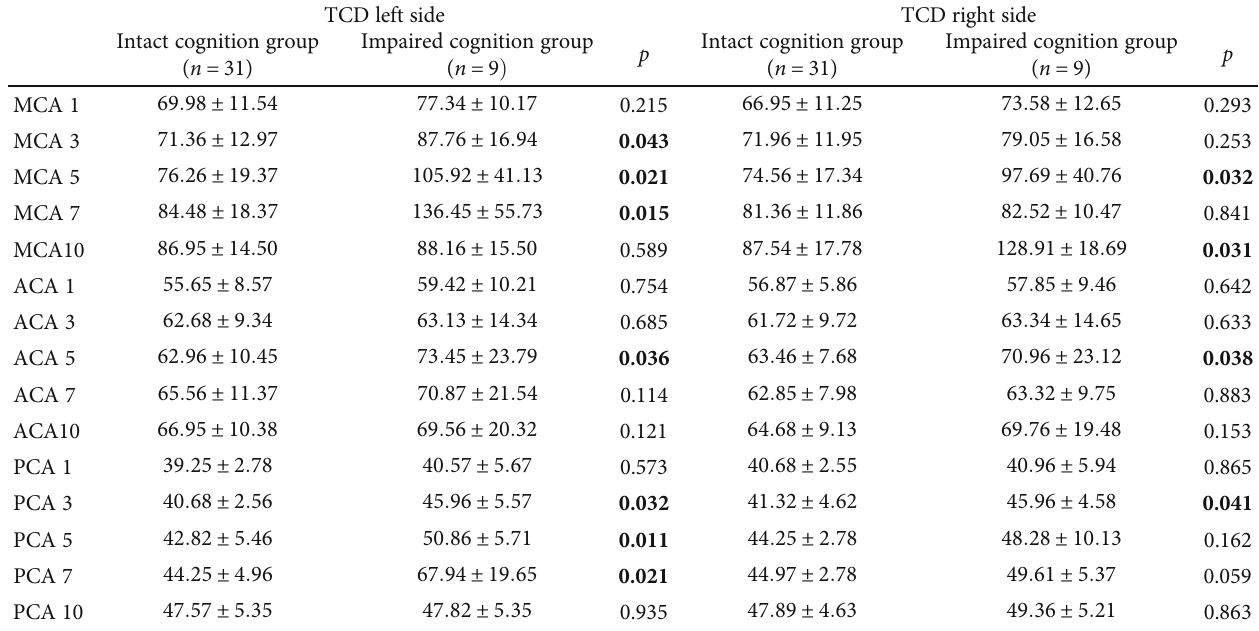
Table 3: TCD parameters (MFV cm/s) in patients with intact cognition and patients with impaired cognition. TCD left side